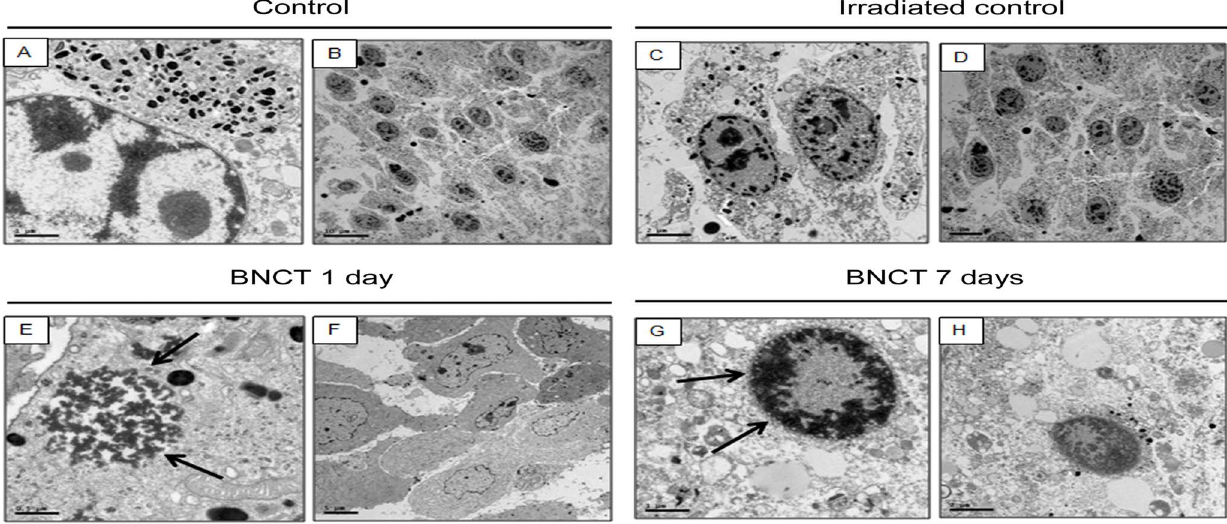
Figure 9. Electron microscopy of melanoma cells from control, irradiated control, BNCT 1 and 7 days groups. (A,C) Detail of the preserved chromatin in the nuclei of melanoma cells from control and irradiated control groups. (B, D) Illustration of the high density population. By contrast, in panels (E, G, H), melanoma cells show a markedly condensed chromatin close to the nuclear membrane (arrows) 1 and 7 days after BNCT. (F) Decrease in cell density after BNCT. The organelles inside the melanoma cells appeared to be degenerated in both BNCT groups.